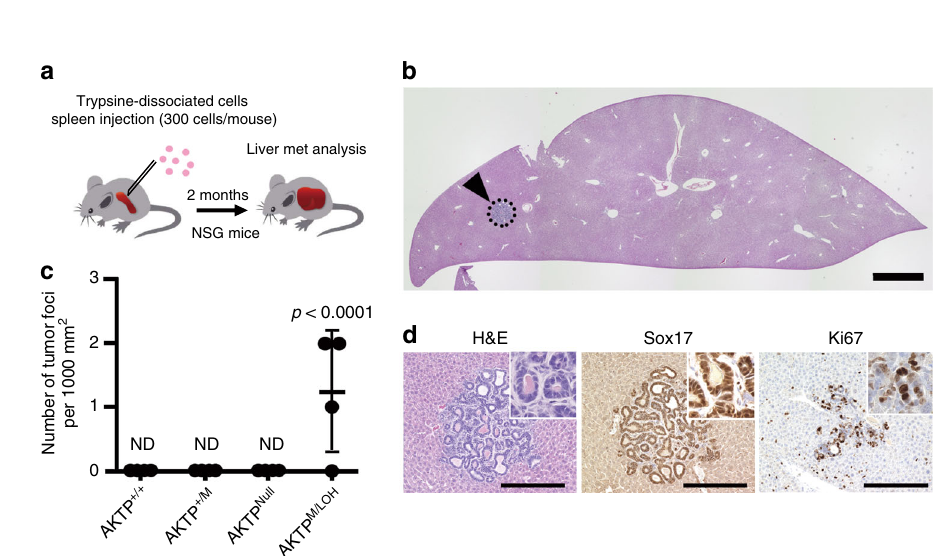
Fig. 5 Enhanced tumor-initiating ability by Trp53 GOF mutation with LOH. a Strategy of subcutaneous (s.c.) tumor development in NSG mice. b The s.c. tumor size changes in each site injected with 1 × 10 2 trypsin-dissociated cells of the indicated genotypes are shown as line graphs. The total number of injected sites ( n = 14) is indicated in each graph. Each line with closed or open circles, squares, diamonds, or triangles indicates the kinetic tumor size development of an individual tumor. c The total number of developed tumors ( y -axis) at the 14 injected sites is shown by red bars. Blue bars indicate number of sites where tumors did not develop. The ratio (%) of tumor development is indicated inside each bar. d The s.c. tumor size changes in each site injected with 5 × 10 3 mechanically dissociated cells of the indicated genotypes are shown as line graphs. The total number of injected sites ( n = 15) is indicated in each graph. Each line with closed or open circles, squares, diamonds, or triangles indicates the kinetic tumor size development of an individual tumor. e The total number of developed tumors ( y -axis) at the 15 injected sites is shown. The ratio (%) is indicated inside each bar. f Representative histology photographs of s.c. tumors that developed from 1 × 10 2 trypsin-dissociated cells. Cell genotypes are indicated in the left. H&E and immunohistochemistry for Ki67, p53, and double fl uorescent immunohistochemistry for α -smooth muscle active ( α SMA) (green)/E-cadherin (Ecad) (red) are shown. The insets show enlarged images. Bars, 200 µ m. Source data are provided as a Source data fi le.